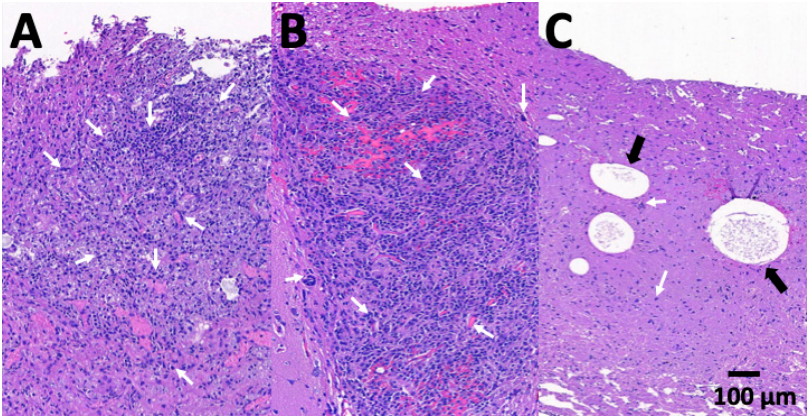
Figure 9. Histological brain tissue examination. Many dark blue granulocytes and macrophages (indicated by short, white arrows) di ff usely infiltrated in the abscess area in ( A ), group A and ( B ), group B. After treatment with vancomycin-embedded poly(lactide- co -glycolide acid) microparticles, few inflammation cells were observed in ( C ), group C. Some residual particles were observed (indicated by black arrows).